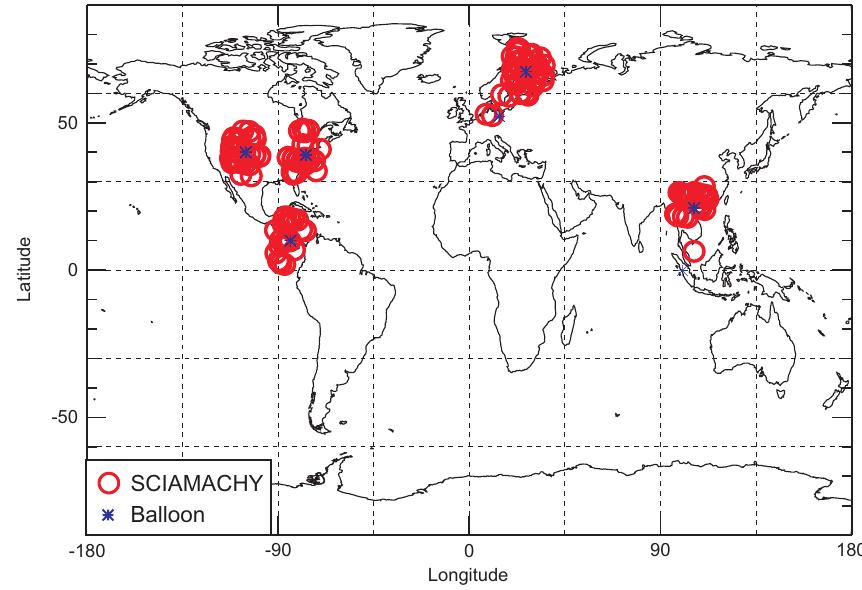
Fig. 19. Locations of balloon launch sites considered in this study and tangent points of coinciding SCIAMACHY observations.